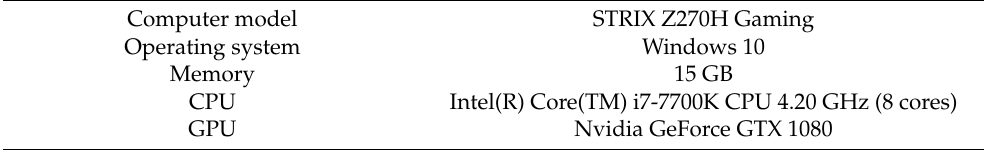
Table 2. Computer configuration applied in our